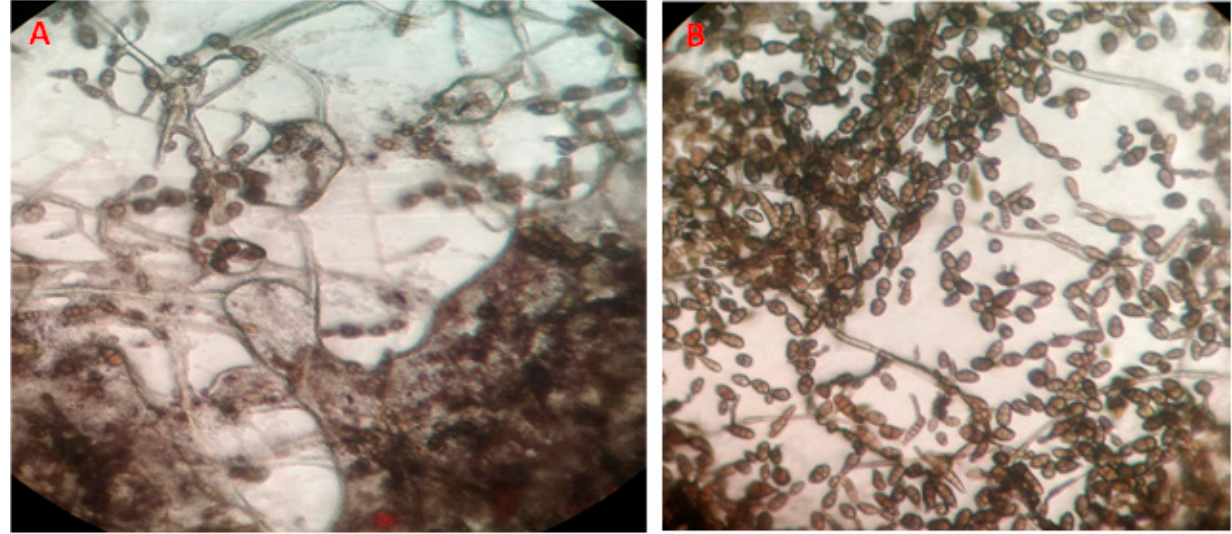
Figure 4. Light microscopic image (200×) of conidia of Alternaria alternata grown on PDA for 7 days after incubation, where ( A ) is influenced by Nano-Se (100 ppm) and ( B ) is the negative control with no treatment.